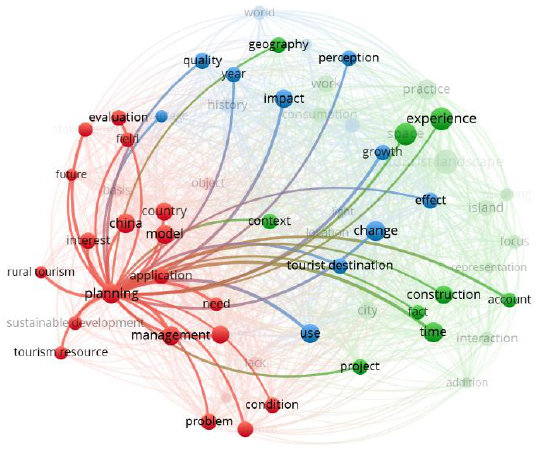
Figure 5. Co-occurrence t erm map by VOSviewer. Focus on the recurrent keyword: “Planning”.